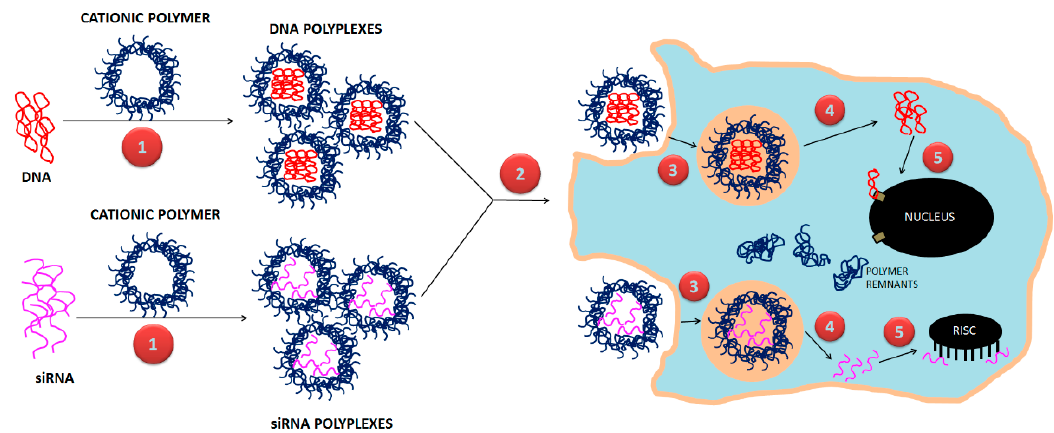
Figure 1. Polymeric nanoparticles for the intracellular delivery of DNA and siRNA: (1) complexation of anionic DNA and siRNA with cationic polymers to form polyplexes (2) cellular uptake of polyplexes via di ff erent endocytic routes, (3) enclosure and subsequent release of polyplexes from endo-lysosomal compartments, (4) release of free DNA and siRNA from polyplexes leaving behind polymer remnants, and (5) transfer of DNA to the nucleus for expression by nuclear membrane transport proteins and binding of siRNA by RNA-induced silencing complex